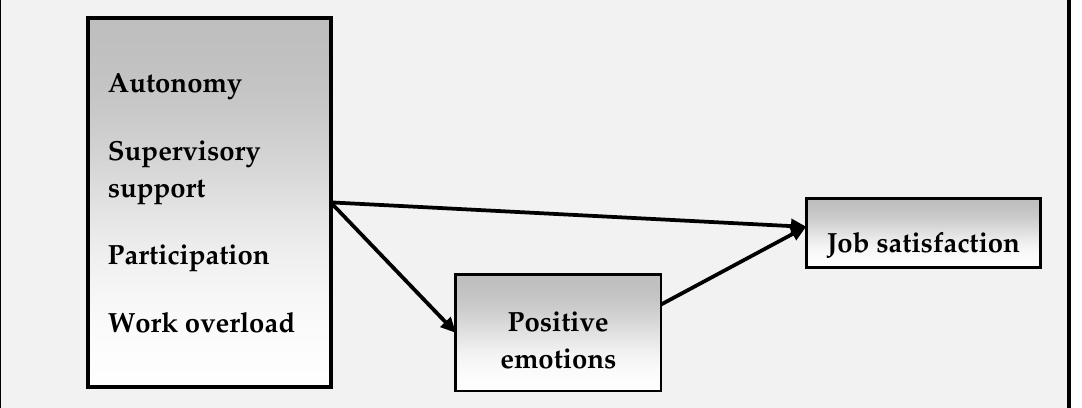
Fig. 1. Proposed model of determinants on job satisfaction for a South African municipality Source: adapted from Skosana (2016).